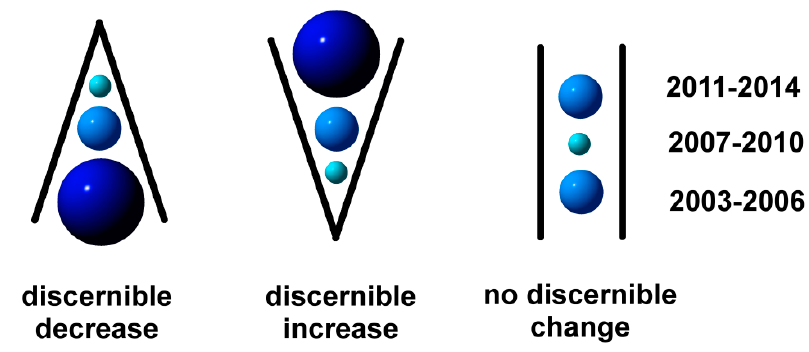
Figure 4. Ternary Visual Shape Logic diagram for the analyzed groundwater changes in 2003–2014. Source: Ziolkowska and Reyes [41].